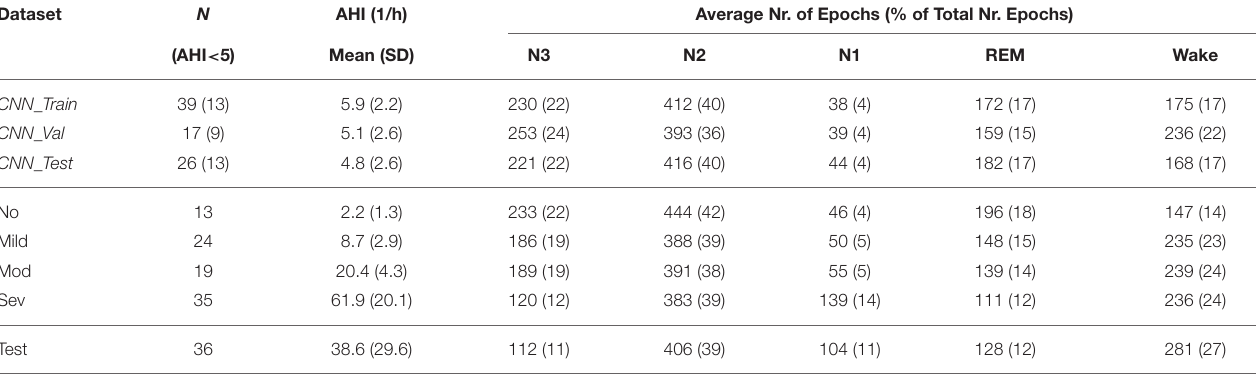
FIGURE 1 | Framework pipeline from polysomnography (PSG) data to Total Sleep Time (TST) estimation and detection of OSA patients. First, the electrocardiogram (ECG) and respiratory inductance plethysmogram (RIP) data were preprocessed (section 2.2). The classifier’s architecture was based on a convolutional neural network (CNN). Its training procedure and derived TST outcome is reported in section 2.3. The relation between uncertainties and sleep-wake transitions in a patient’s prediction and the obstructive sleep apnea (OSA) severity were studied in section 2.4.1. These relations were subsequently applied for detection of OSA patients (section 2.4.2). The gray boxes indicate the datasets used for parameter optimization or selection. TABLE 1 | Demographic and clinical information of the study